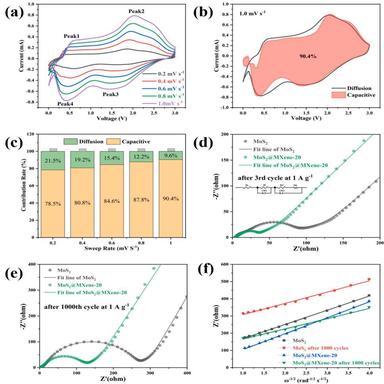
MoS2@MXene-20 composite (a) CV curves at different scanning rates, (b) log (v) and log (i) diagrams at different scanning rates, (c) Capacitive contribution at different scanning rates, (d-f) EIS curves of MoS2 and MoS2@MXene-20 composite after the 3rd cycle and the 1000th cycle, (f) the relationships between Z' and ω− 1/2 according to EIS data.